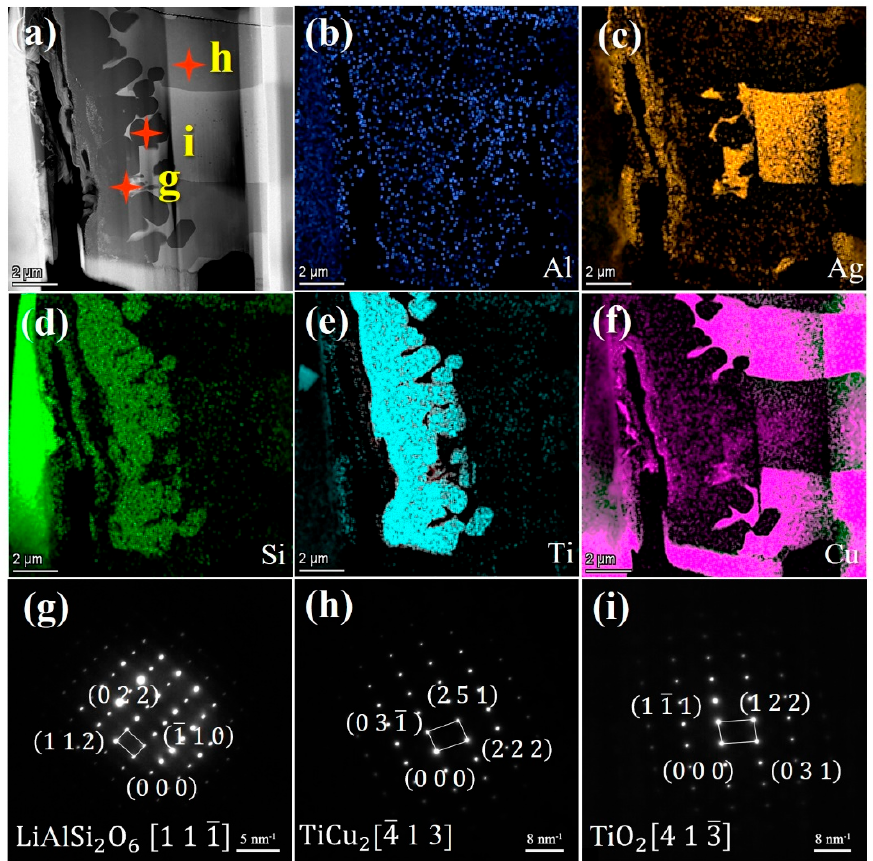
Figure 6. ( a ) HAADF images of SiC joints brazed with AgCuTi + 1 wt% LiAlSiO 4 at 900°C for 10 min; ( b – f ) elemental distributions corresponding to Al, Ag, Si, Ti, Cu; ( g – i ) selected area electron diffraction (SAED) patterns corresponding to the three points in figure ( a ).